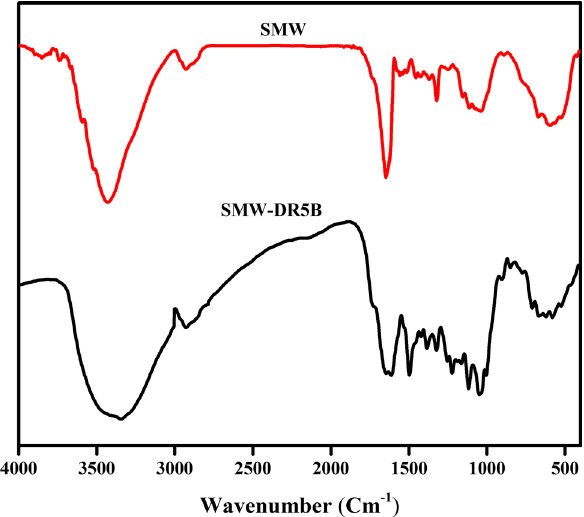
Fig. 8 Fourier transform infrared spectra of pristine and DR5B- loaded spent mushroom